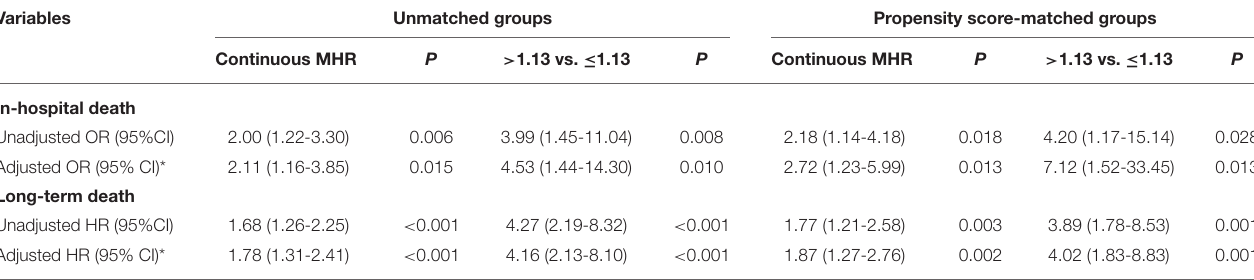
TABLE 2 | Association of preoperative monocyte to high-density lipoprotein ratio (MHR) on in-hospital and long-term death before and after propensity score matching. Variables